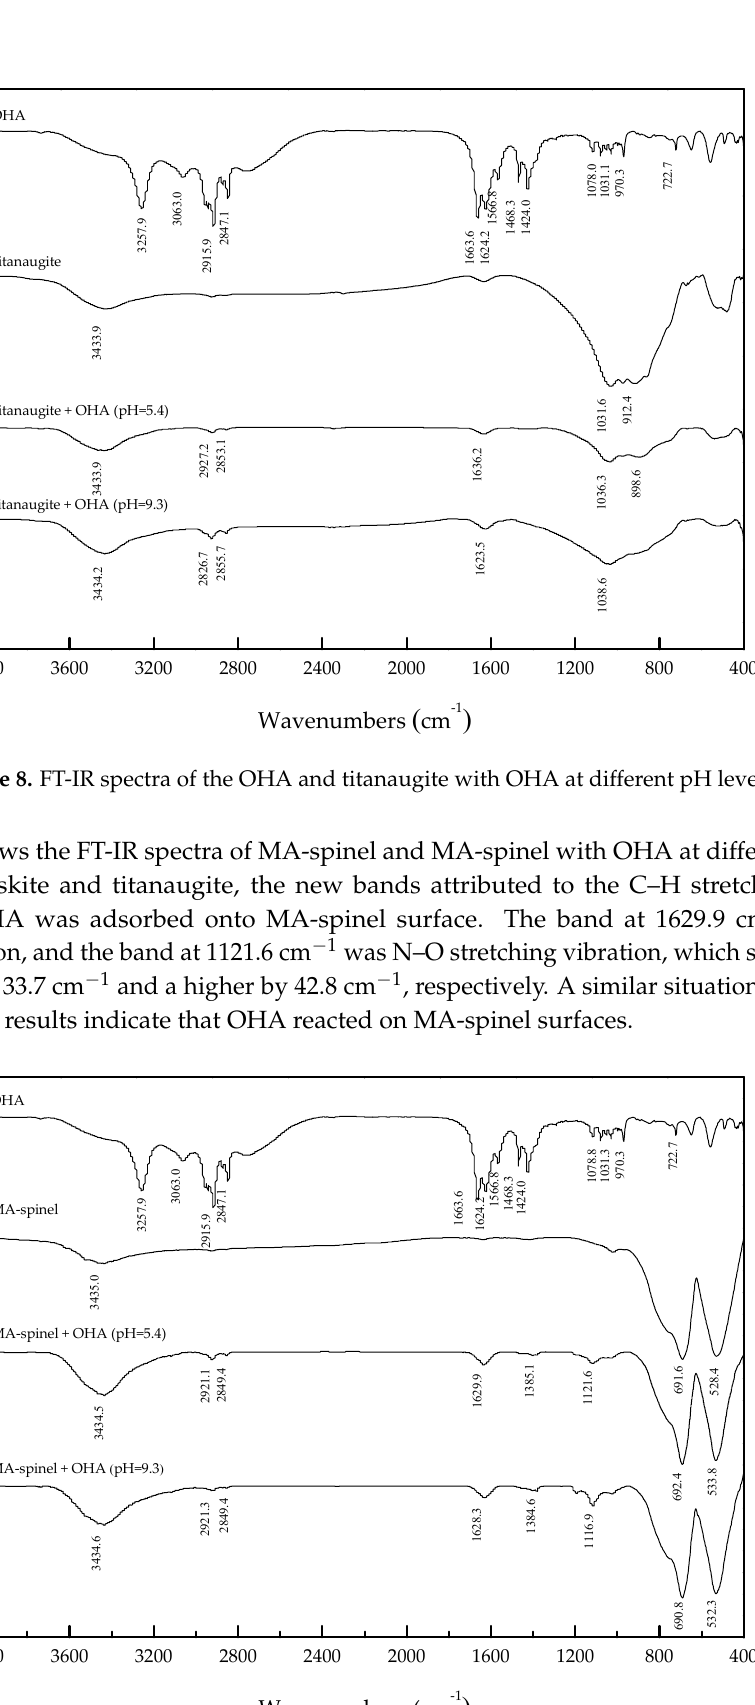
Figure 9. FT-IR spectra of the OHA and MA-spinel with OHA at different pH levels.